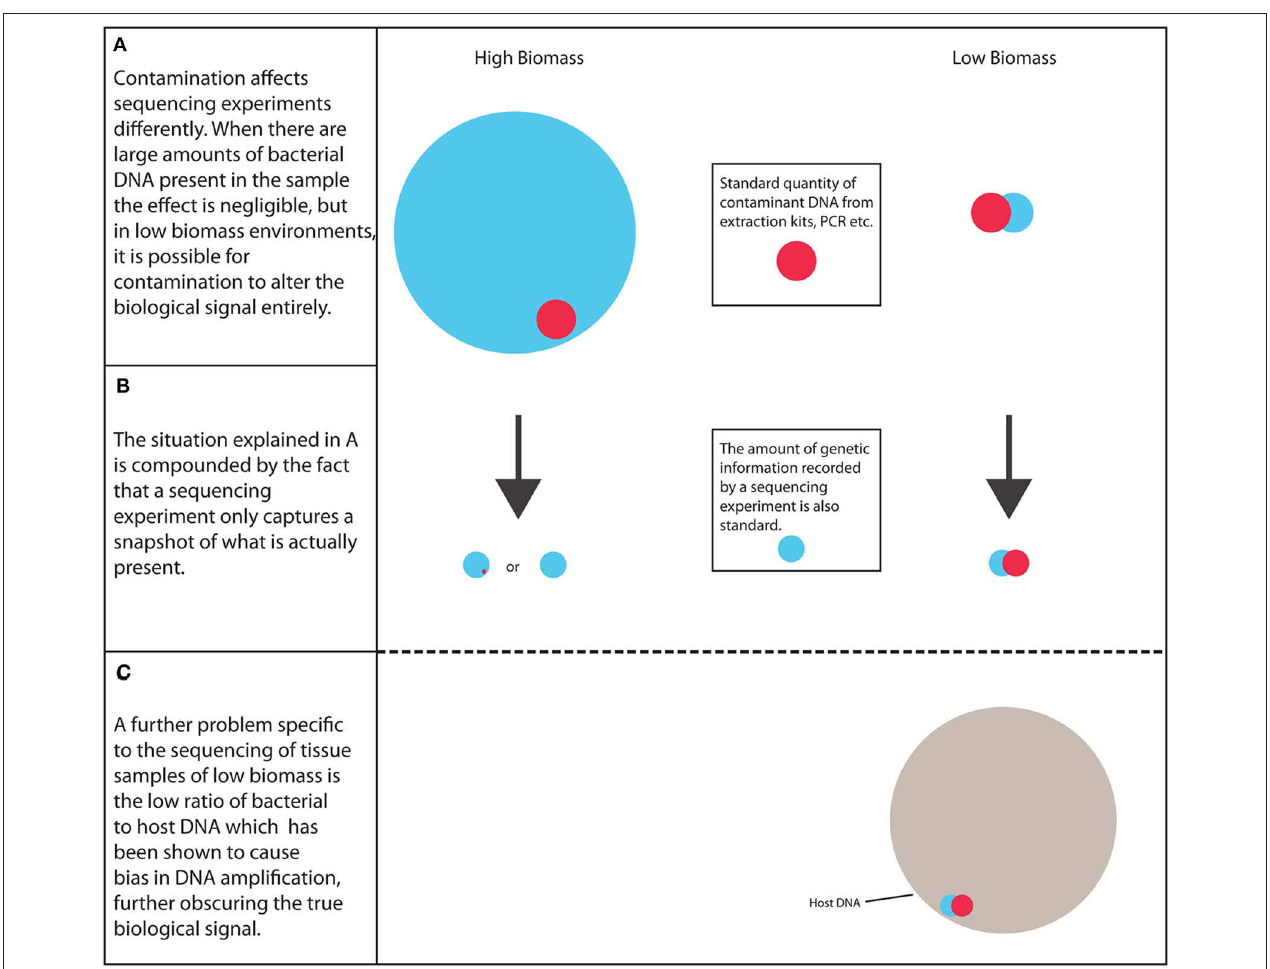
FIGURE 1 | The scale of the problem. Low biomass environments are considerably more susceptible to biological signal alteration arising from contaminant DNA than high biomass samples, along with the increased likelihood of PCR